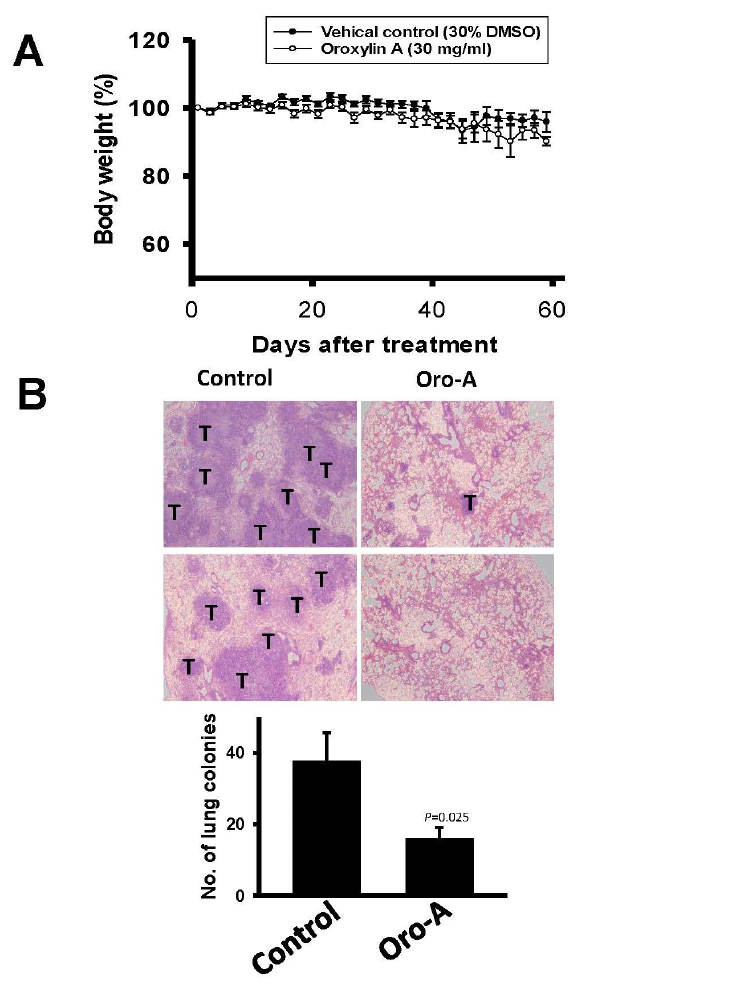
Figure 8. Oro-A inhibits metastasis in vivo. ( A ) Mouse body weights were measured every 2 days, and the results are presented as the means ± SEM. ( B ) Representative photographs of hematoxylin- and eosin- (HE) staining lungs from 30% DMSO (vehicle control) and Oro-A group mice. “T” indicates tumor cells. Number of lung nodules in HE-stained lung sections in vehicle control and Oro-A groups. P values were determined using Student’s t